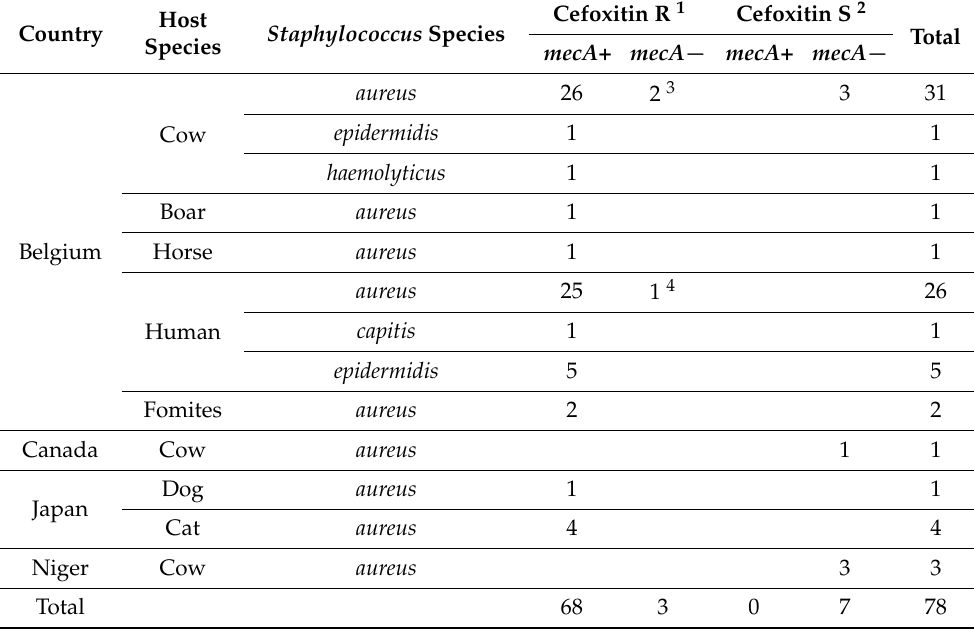
Table 1. Cefoxitin susceptibility test vs. mecA PCR on the 78 staphylococci growing on Chrom MRSA